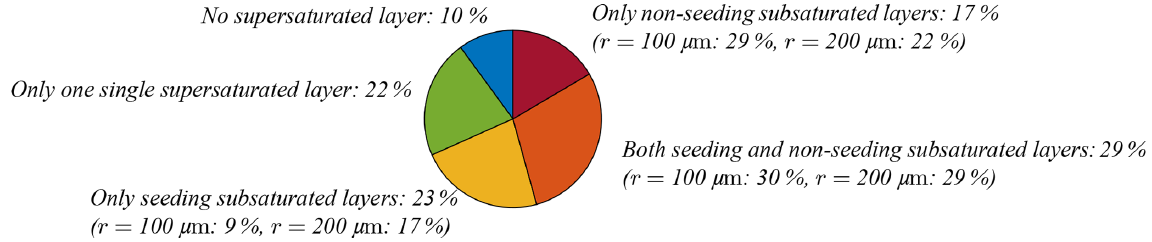
Figure 5. Classification step 1 using a hexagonal plate as the initial ice crystal with the size of r = 400µm. Relative occurrence of supersat- urated layers, as well as seeding and non-seeding subsaturated layers. A total of 100% equals 278 relative humidity profiles. Percentages in brackets refer to the calculation using the initial ice crystal sizes r = 100 and 200µm; for the categories “no supersaturated layer” and “only one single supersaturated layer” there are no changes in percentage. The values are rounded to zero decimal places.